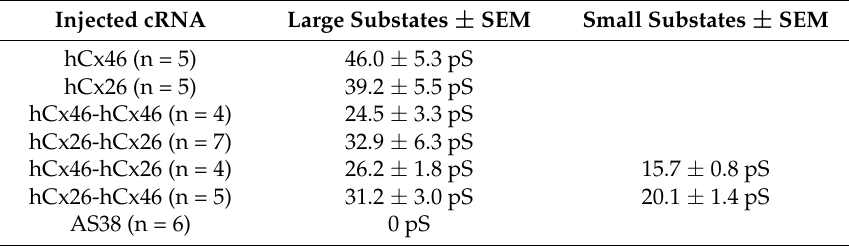
Figure 4. Analysis of single hemichannels formed by concatemeric connexins. The stripped membrane of Xenopus oocytes, which were injected with hCx46, hCx26, or the four different concatemeric constructs, as well as the AS38 (control) cRNA 24 h before, was used to perform the inside-out patch-clamp recordings. The measurements were performed in presence of Cs + and in absence of Cl − on both sides of the membrane. ( A ) Examples of single channel currents elicited by a depolarizing voltage pulse of +50 mV in absence of Ca 2+ in the bath solution are shown. ( B ) The open probability of all measured single channels was analyzed. The error bars represent the SEM. The data were evaluated by a one-way ANOVA followed by a Tukey test (* p ≤ 0.05, ** p ≤ 0.01, *** p ≤ 0.001, ns: not significant). The statistical comparison showed that the presence of Ca 2+ or carbenoxolone (CBX) in the bath solution significantly reduced the open probability of all tested variants. Table 2. Conductance states of the hemichannels expressed in Xenopus oocytes as measured in inside out patch-clamp configuration. n gives the number of analyzed